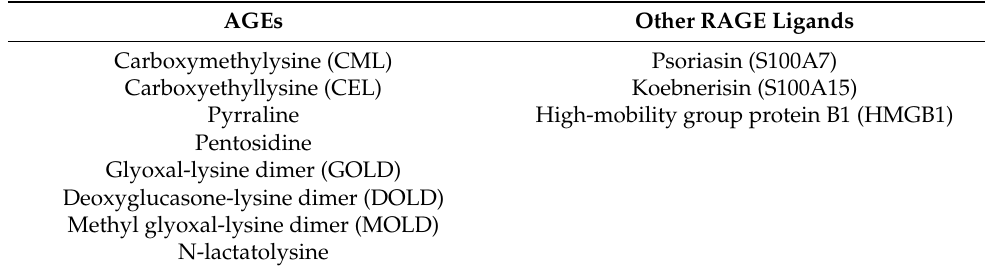
Figure 1. The classical pathway of the Maillard reaction. The open chain form of glucose reacts with lysine to form a Schiff base adduct, which undergoes an Amadori rearrangement to form a ketoamine (fructosamine) adduct to protein [23]. Table 1. Principal advanced glycation end products (AGEs) investigated in patients with psoriasis.